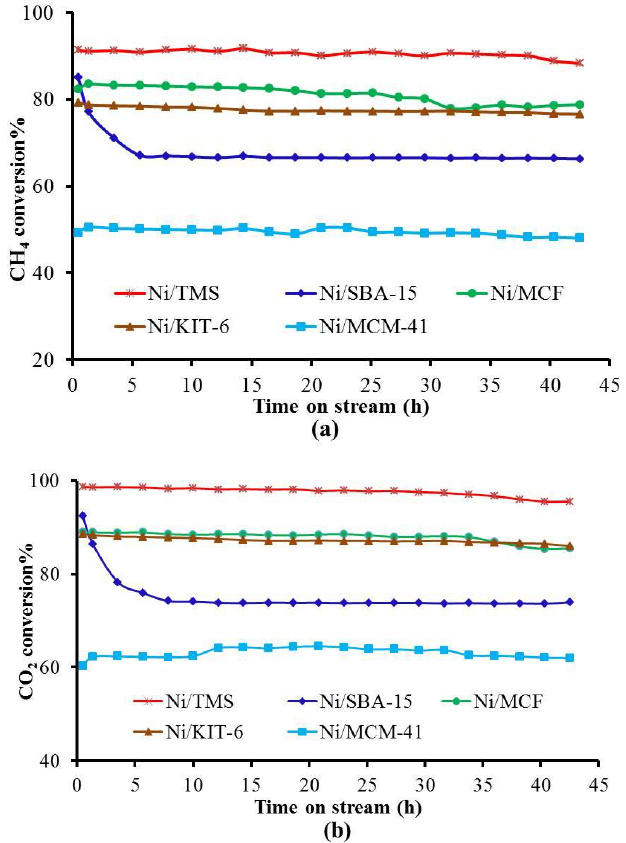
Figure 1. Conversion of ( a ) CH 4 and ( b ) CO 2 over Ni / SiO 2 catalysts (Reaction conditions: Temperature = 700 °C; CO 2 :CH 4 = 1.0; GHSV = 5.2 × 10 4 mLg − 1 h − 1 ; TOS = 43 h). Table 1. Initial and final CH 4 conversion (%) of DRM at ambient pressure and 700 ◦ C over Ni